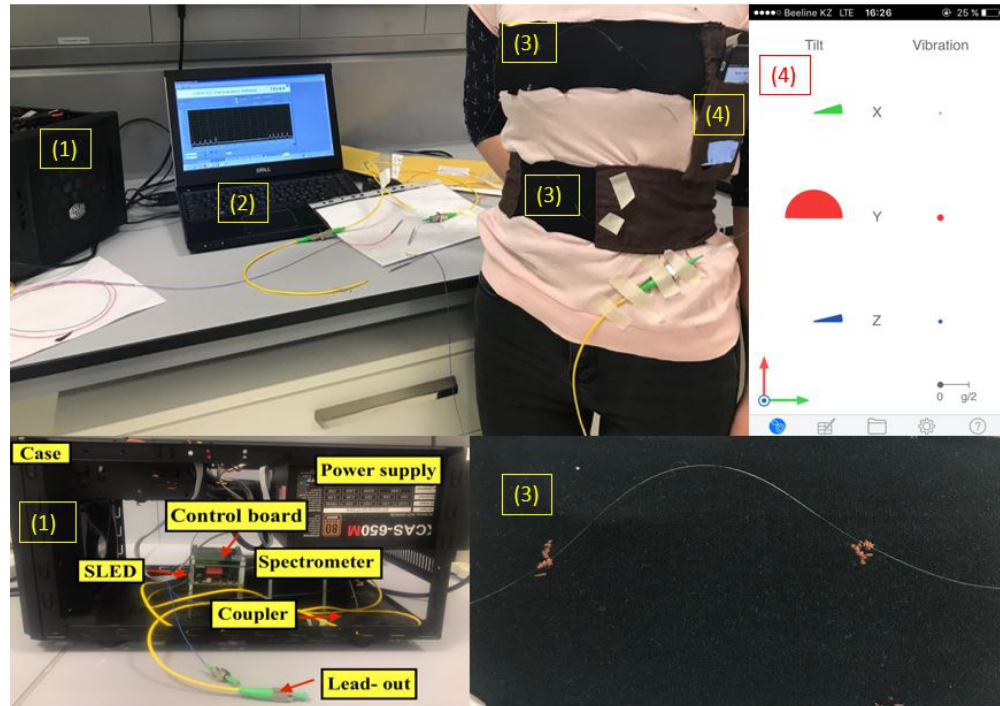
Figure 1. Experimental setup: (1) I-MON interrogator, (2) PC with evaluation software, (3) T-shirt with belts equipped with arrays of 5 FBGs, (4) VibSensor mobile application.